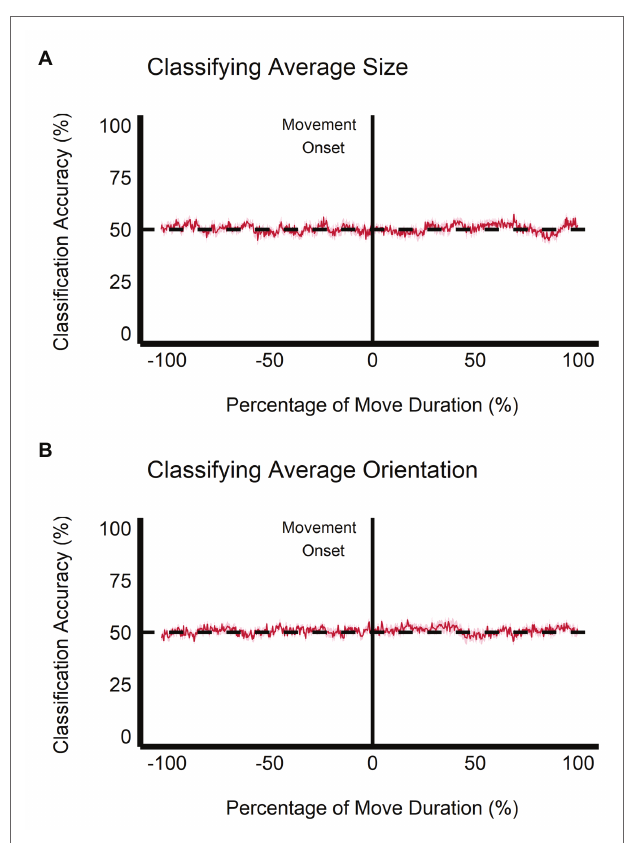
FIGURE 10 | Multivariate results of the grasping task. SVM classification accuracy is plotted for discriminations of (A) average ensemble size (small vs. large) and (B) average ensemble orientation (CW vs. CCW) across the duration of movement. Negative percentage values of movement duration show baseline accuracy values beginning at stimulus onset. Light red region = depicts